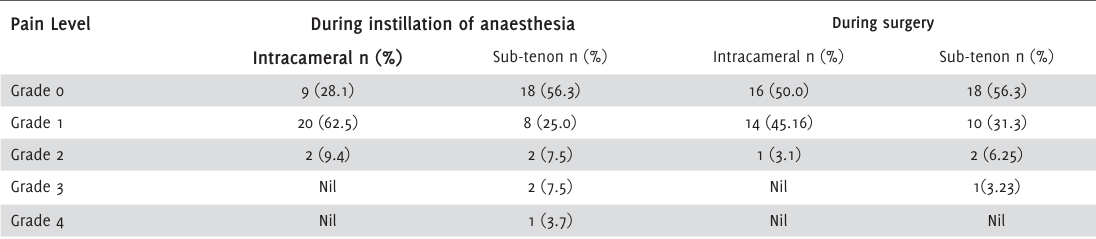
Table 1. Comparison of Pain Level during Instillation of Anaesthesia and during Surgery.